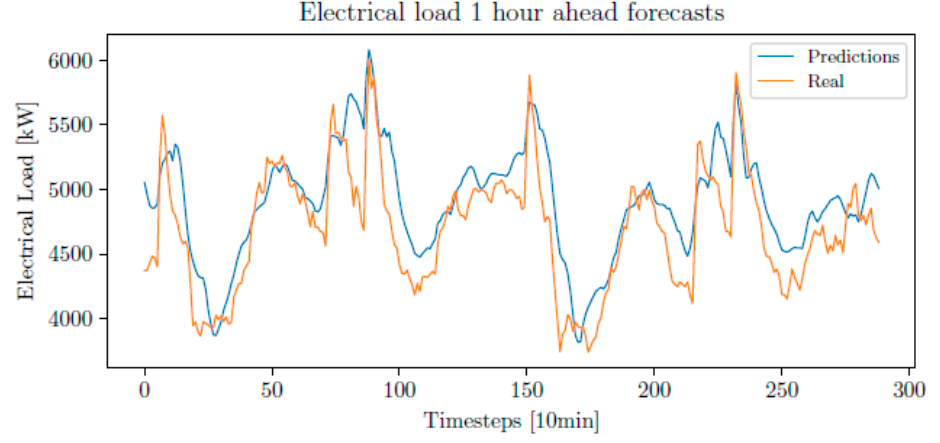
Figure 9. One-hour-ahead initial forecasts.